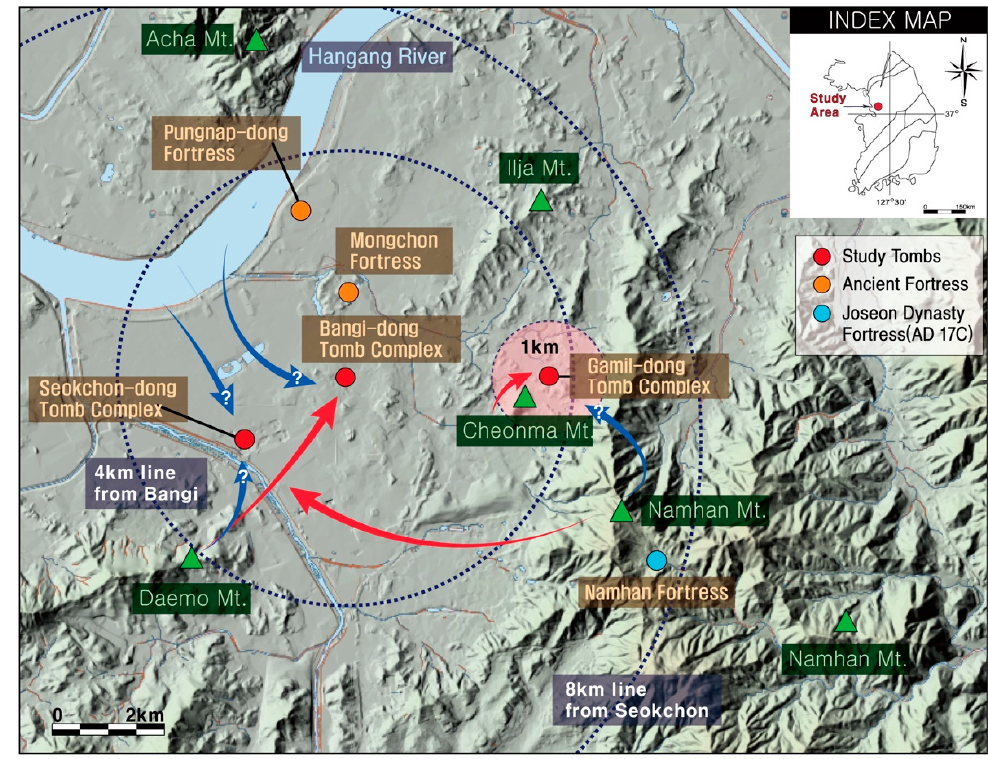
Figure 9. Schematic figure showing the presumption supply route from rock provenance for Korean ancient tombs from the Songpa district in Seoul.